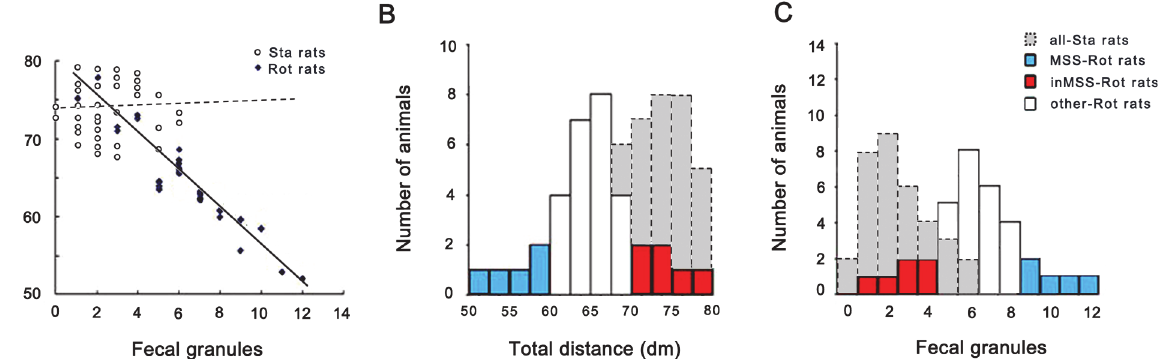
Fig 1. Data analysis for the defecation response and total distance traveled for MS susceptibility evaluation in microarray experiment. (A) Linear relationship between the number of fecal granules and total distance traveled in the Rot and Sta group (n = 34 in each group). The distribution of the number of fecal granules (B) and total distance traveled (C) in staic control (n = 34), MSS-Rot (n = 5), inMSS-Rot (n = 6), and other rotated animals (n = 23).